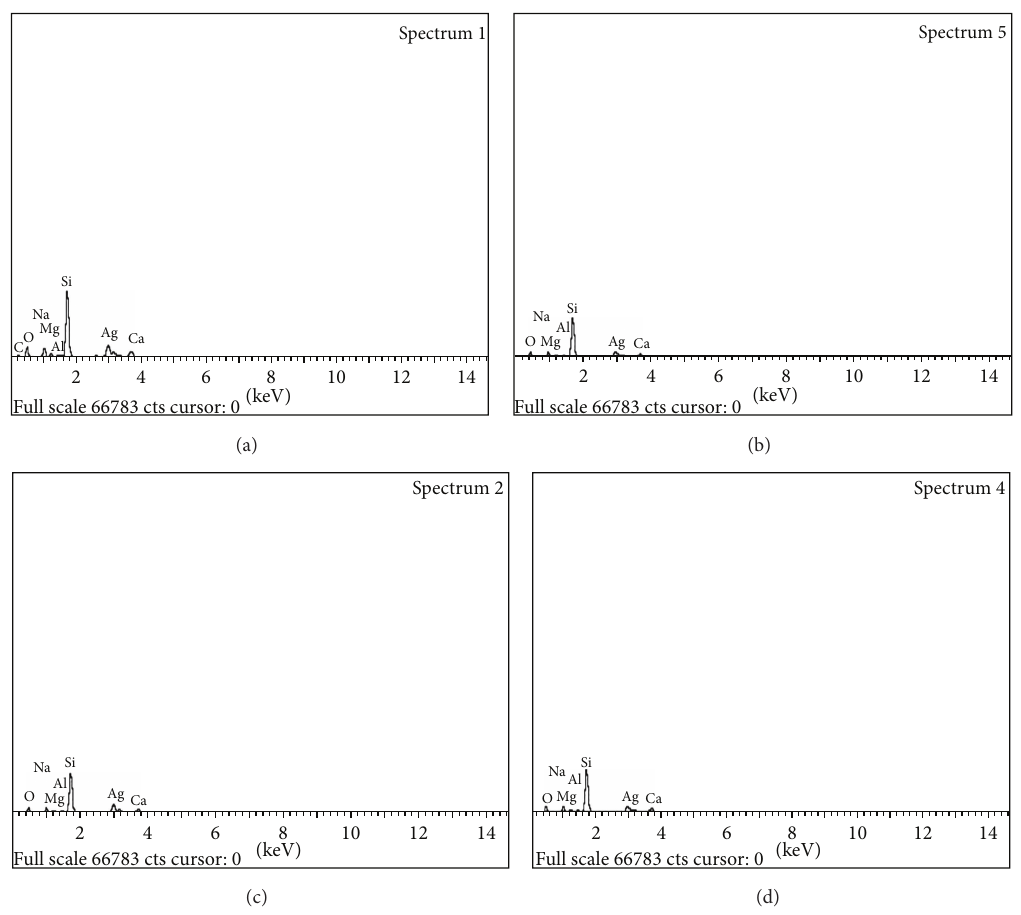
suitable for photothermal and material applications